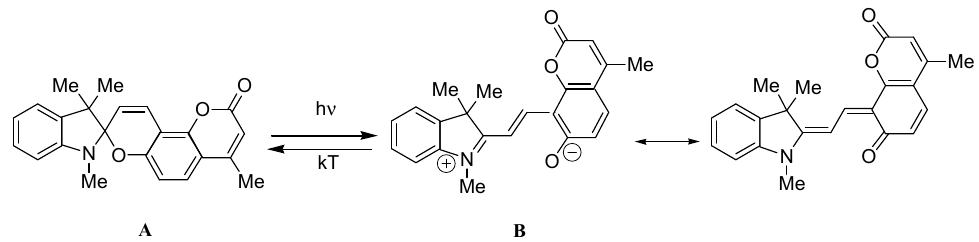
Scheme 2. Photochromic processes in spiropyran 2 .